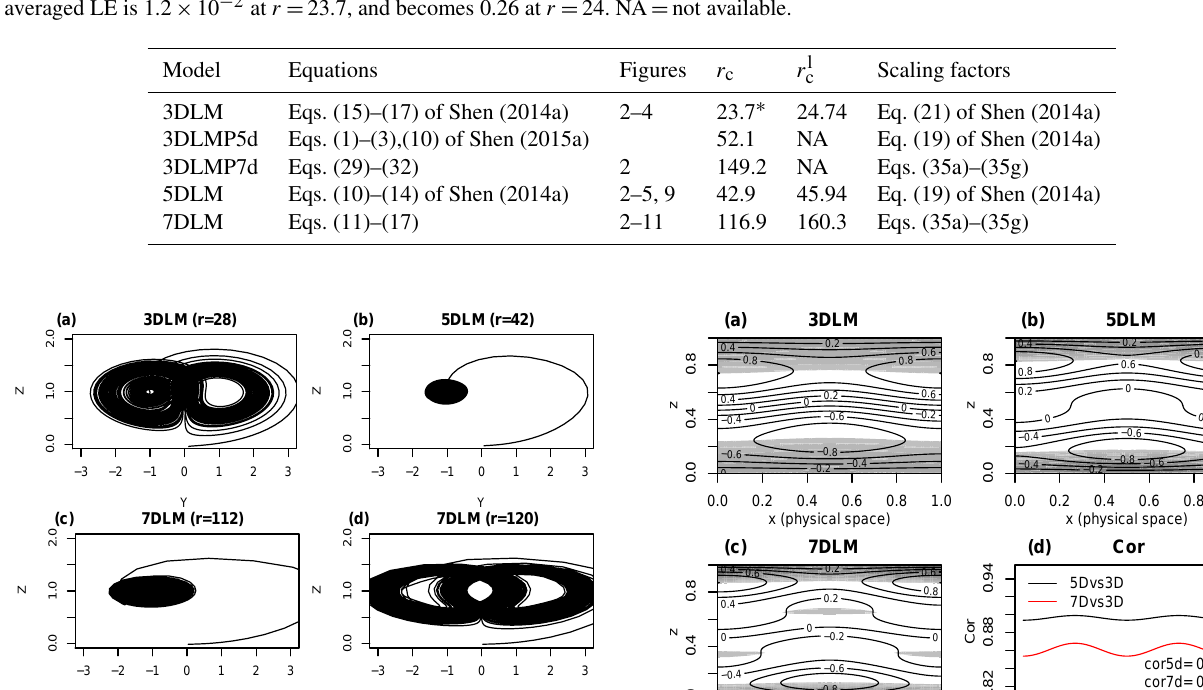
Table 1. The characteristics of various Lorenz models. The “Equations” column provides a list of the equations used in each specific Lorenz model. Values for r c and r l c are determined based on the eLE analyses and the linear stability analysis, respectively. The “Scaling factors” column indicates the analytical solitions of the critical points used to normalize the solutions in Fig. 3. ∗ For the 3DLM, the ensemble averaged LE is 1.2 × 10 − 2 at r = 23.7, and becomes 0.26 at r = 24. NA = not available.